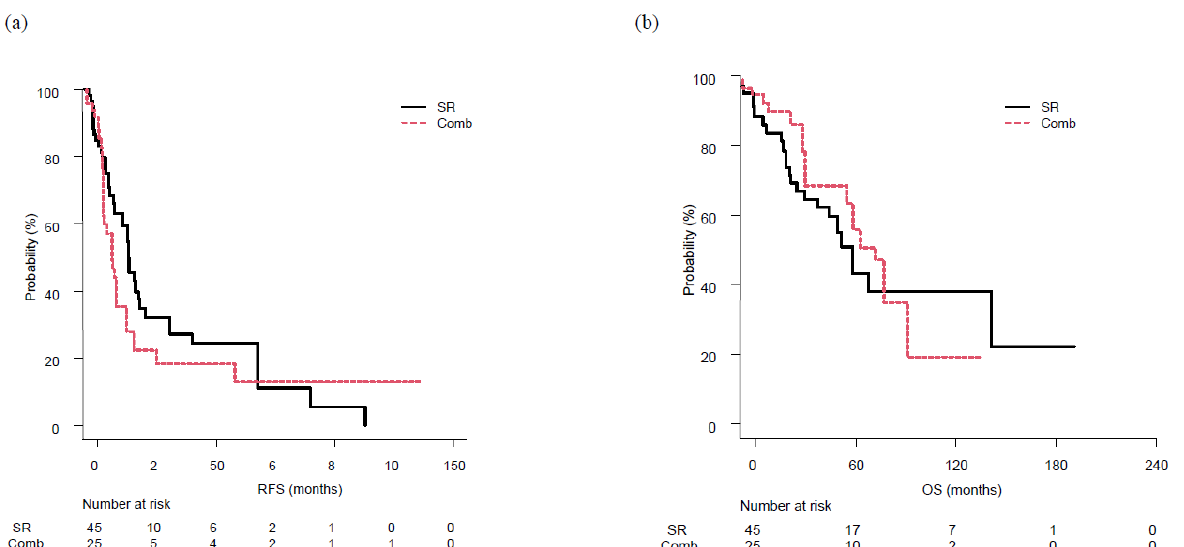
Figure 2. Recurrence-free and overall survival for patients who underwent surgical resection (SR) or combined surgical resection and radiofrequency ablation therapy (Comb). ( a ) There was not sig- nificantly difference of median recurrence-free survival (mRFS) in the SR (17.7 months, 95%CI: 10.3– 22.1) and Comb groups (13.1 months, 95% CI: 9.0–18.9) ( p = 0.70). ( b ) Median overall survival (mOS) of the SR and Comb groups was 66.6 (95% CI: 37.7-not applicable) and 72.0 (95% CI: 37.5–100) months, respectively, not significantly different ( p = 0.544).